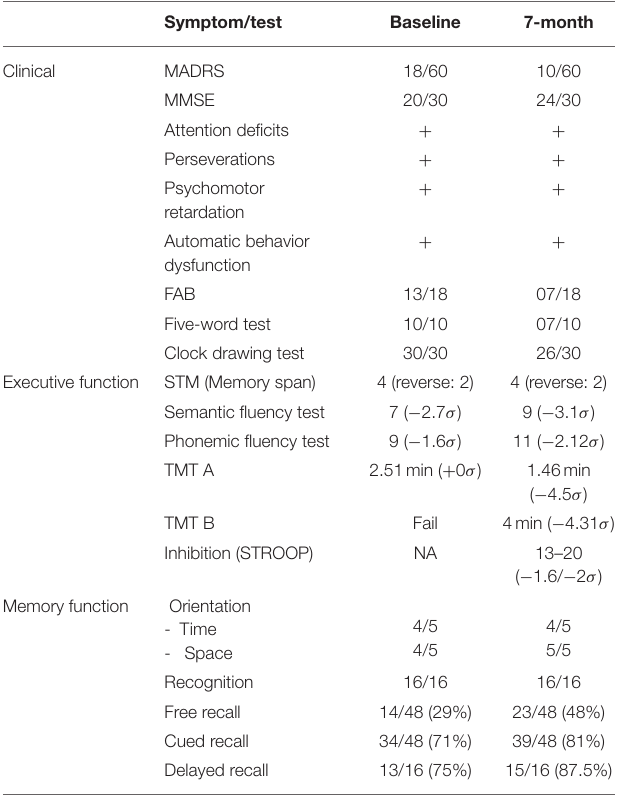
TABLE 1 | Clinical evaluation and main results of neuropsychological examination at baseline and 7 months